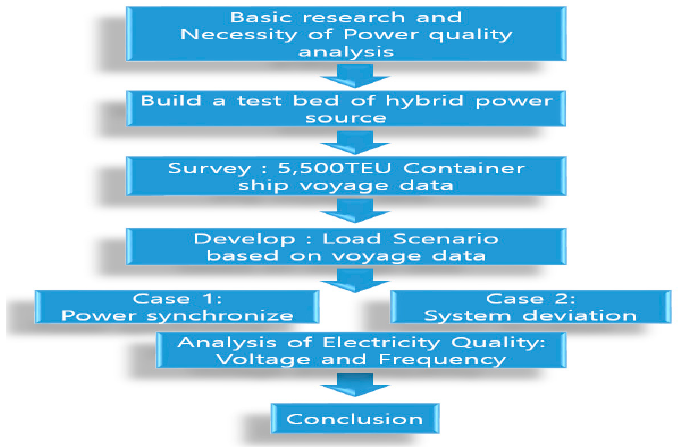
Figure 1. Flowchart for research procedure.